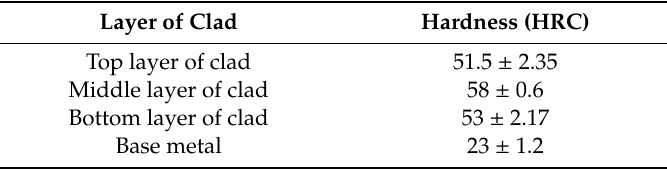
Table 4. Hardness of different layers of clad.